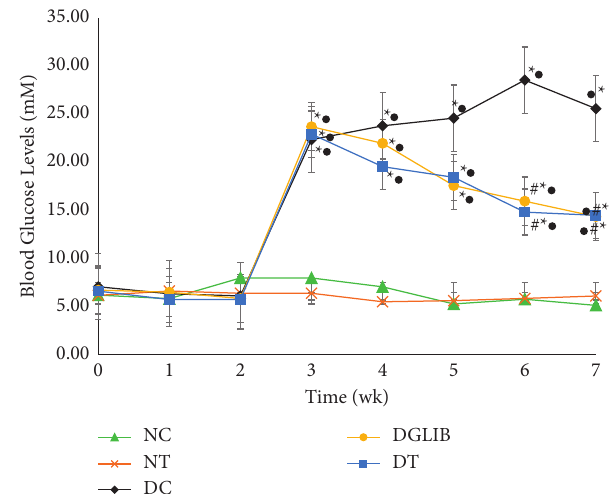
Figure 6: The change in BGL of diabetic and euglycaemic S-D rats following treatment for 28d. Data are expressed as mean- ± standard error of the mean and analysed by Tukey post host statistical test. NC: normal control, NT: normal treatment, DC: diabetic control, DT: diabetic treatment, DGlib:diabetic gliben- clamide group. ∗ indicates statistically significant difference when compared with NC. # indicates statistically significant difference when compared with DC. • indicates statistically significant dif- ference when compared NT, where statistically significant differ- ence is expressed as p ≤ 0 .